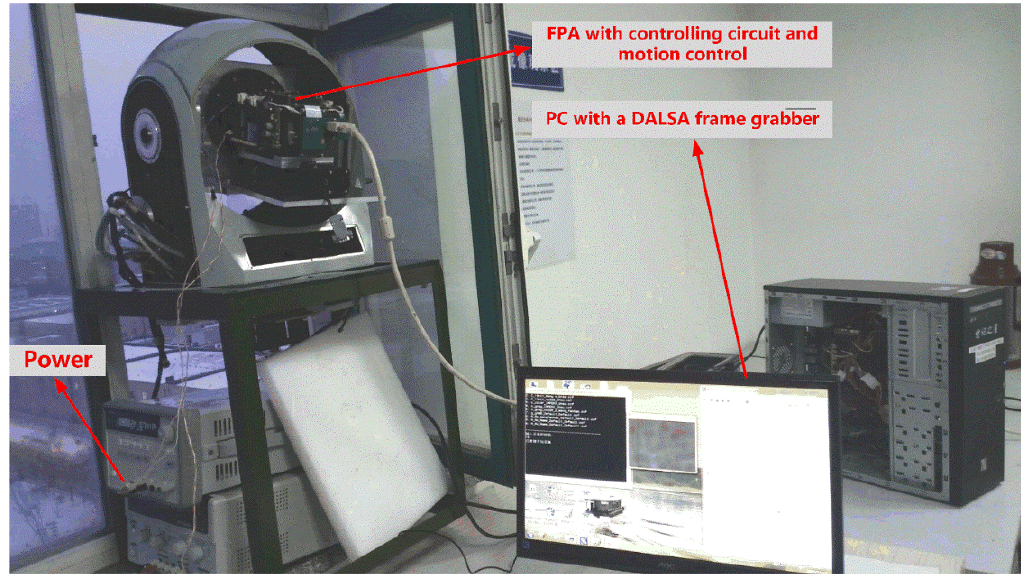
Figure 8. Experimental devices of scene-based NUC calibration.